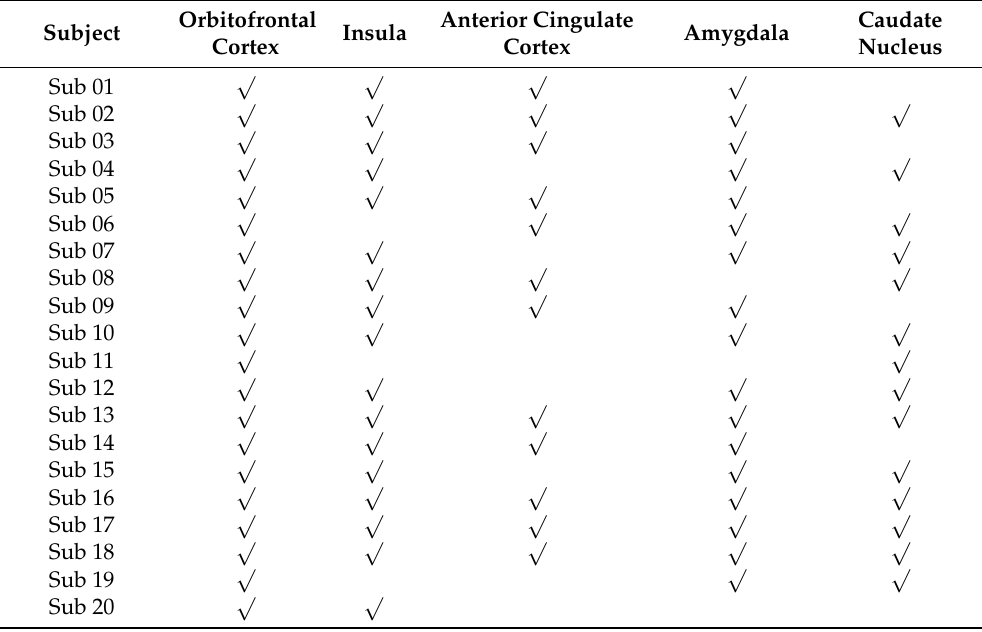
Table 2. Partial activated ROIs of all subjects of both winning and losing